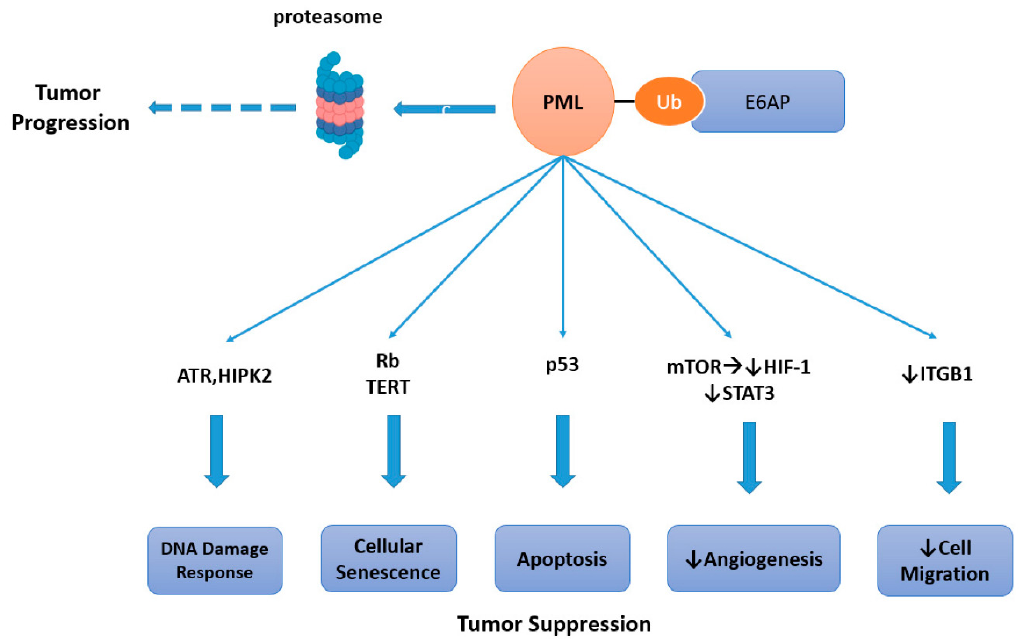
Figure 2. E6AP ubiquitinates promyelocytic leukemia protein (PML) and leads to tumor